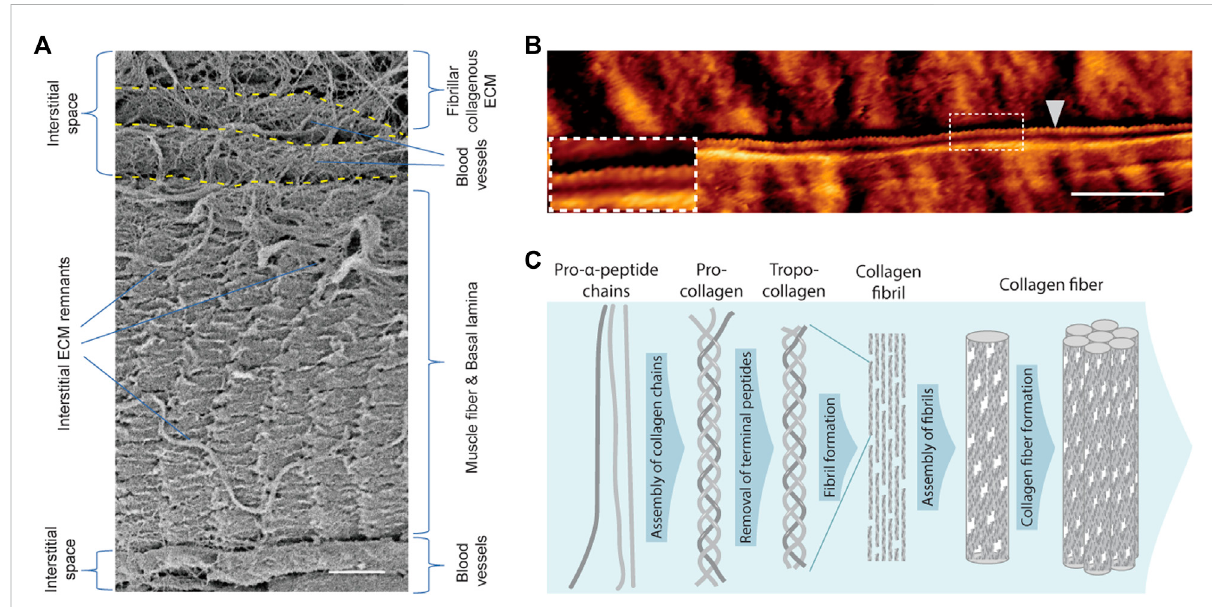
FIGURE 3 Fibrillar collagen and the interstitial space. (A) Scanning electron microscopy image of a manually teased mouse muscle fi ber bundle preparation. The fi ber is covered by the basal lamina and residues of interstitial ECM proteins. Flanking the fi ber several ECM-covered blood vessels embeddedintheinterstitialspacecanbediscerned.TheuppermostpartoftheimageshowstheextensivecollagenIandIII-richECMnetworkinthe interstitial space of skeletal muscle. (B) Atomic force microscopy image (contact mode) of a single collagen fi bril (white arrowhead) on the surface of an enzymatically isolated single mouse muscle fi ber. The characteristic banding pattern of overlap and gap regions of the collagen fi bril can be discerned in the insert. (C) Scheme illustrating the fi ber assembly process of collagen I. Scale bars = 2 µm (A) , and 1 µm (B)